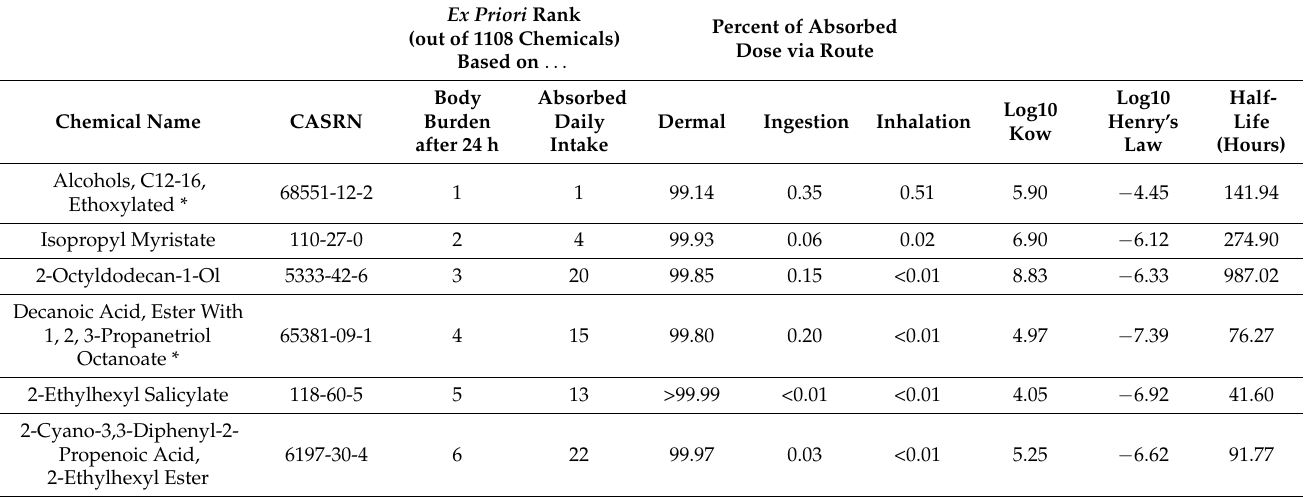
Table 2. Subset of chemical rankings (top 20 of 1108), with rankings by exposure route. All route and product category weights are set to 1, and all parameters take their default value. ((*) = polymers and/or mixtures; does not necessarily apply to each component of a mixture and does not apply to a single sub-unit of a